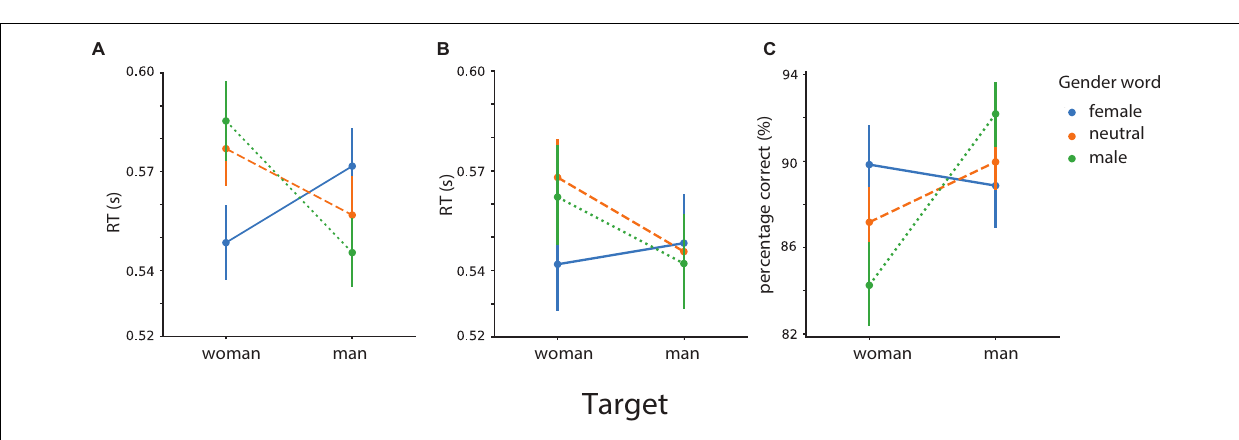
over multiple samples, indicate that the fitting routines have converged to a fixed estimate. An R-hat statistic below